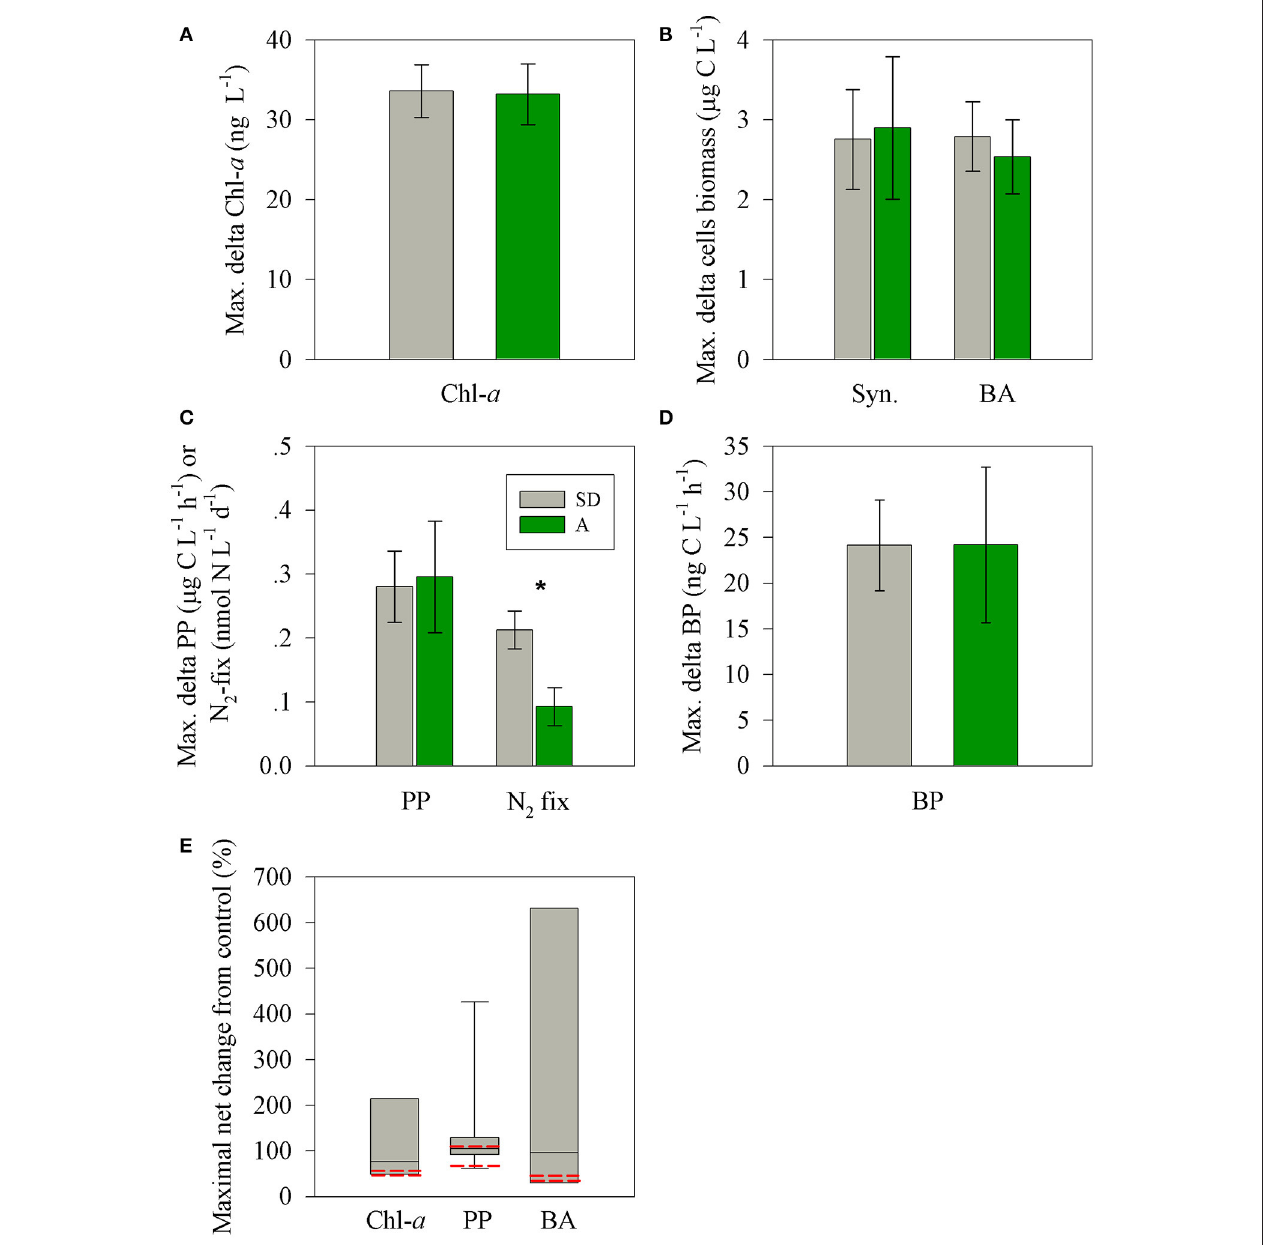
FIGURE 5 | The observed maximal net changes of for the autotrophic and heterotrophic microbial variables (A–D) following SD (gray) or A (green) additions in the surface EMS during May 2012 and a box plot distribution of the net change reported for chl- a , PP, and BP in Mediterranean Sea studies. Data were taken from Herut et al. (2005); Ternon et al. (2011); Ridame et al. (2013); Rahav et al. (2016b); Rahav et al., unpublished and this study (E) . The red lines represents the observed values measured for SD and A during this study. The asterisks above the columns represent statistically significant differences (one-way ANOVA and a Fisher LSD means comparison test, P < 0.05) for mean values of P additions between